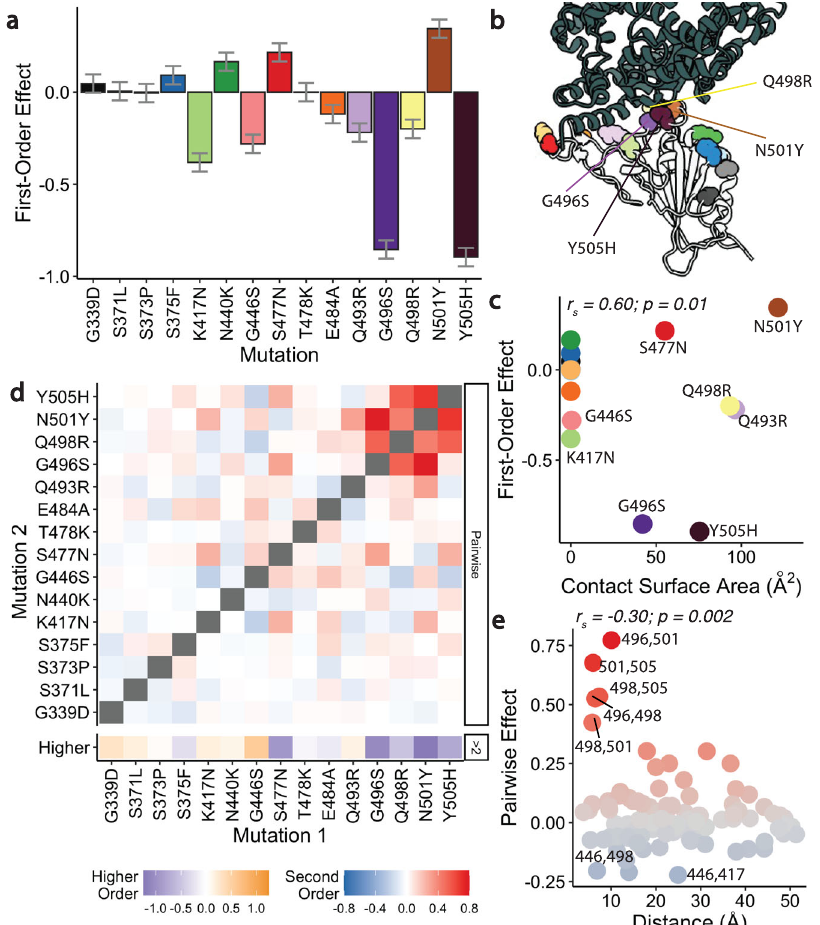
Fig. 2 | Linear and epistatic effects of mutations. a First-order effects in best- fi ttingepistaticinteraction model (up to fi fth order). Errorbarsrepresent standard errors from the model fi t, and are centered on the mean, n=16,384. b Co-crystal structure of Omicron BA.1 RBD and ACE2 receptor (PDB ID 7WPB). Mutated resi- dues shown as spheres colored as in ( a ). c First-order effects for each mutation plotted against contact surfacearea between corresponding BA.1 RBDresidue and ACE2. Mutations colored as in ( a ). The Spearman ’ s rank correlation coef fi cient (r s ) between fi rst-order effect and contact surface area is indicated in the top-left.